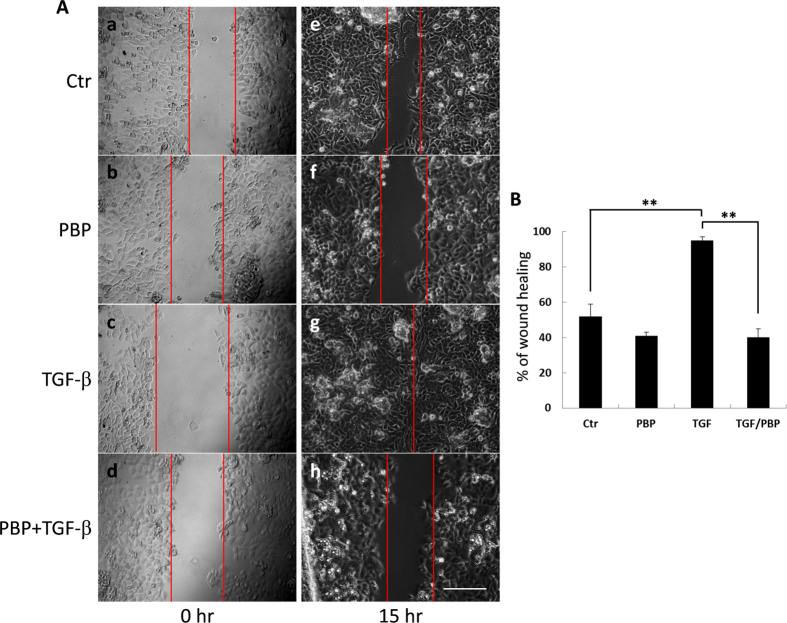
PBP inhibits TGF-β-induced motility of A549 cells.(A) A549 cells grown on a 4-chambered 35-mm dish were starved in DMEM containing 0.1% FCS for 12 h before wounding. Wounded cells were treated with TGF-β (100 pM) ± PBP (5 μM) for the indicated time. Cell motility was measured using a phase-contrast microscope at 100 × magnification. Cell migration was observed by performing time-lapse microscopy and imaging at 0 and 15 h after wounding. (B) Percentage of wound closure was calculated from the mean ± SD (error bars) of eight wound widths per condition measured at 15 h. One representative experiment out of three independent experiments is shown (**P < 0.01); scale bar = 200 μm.